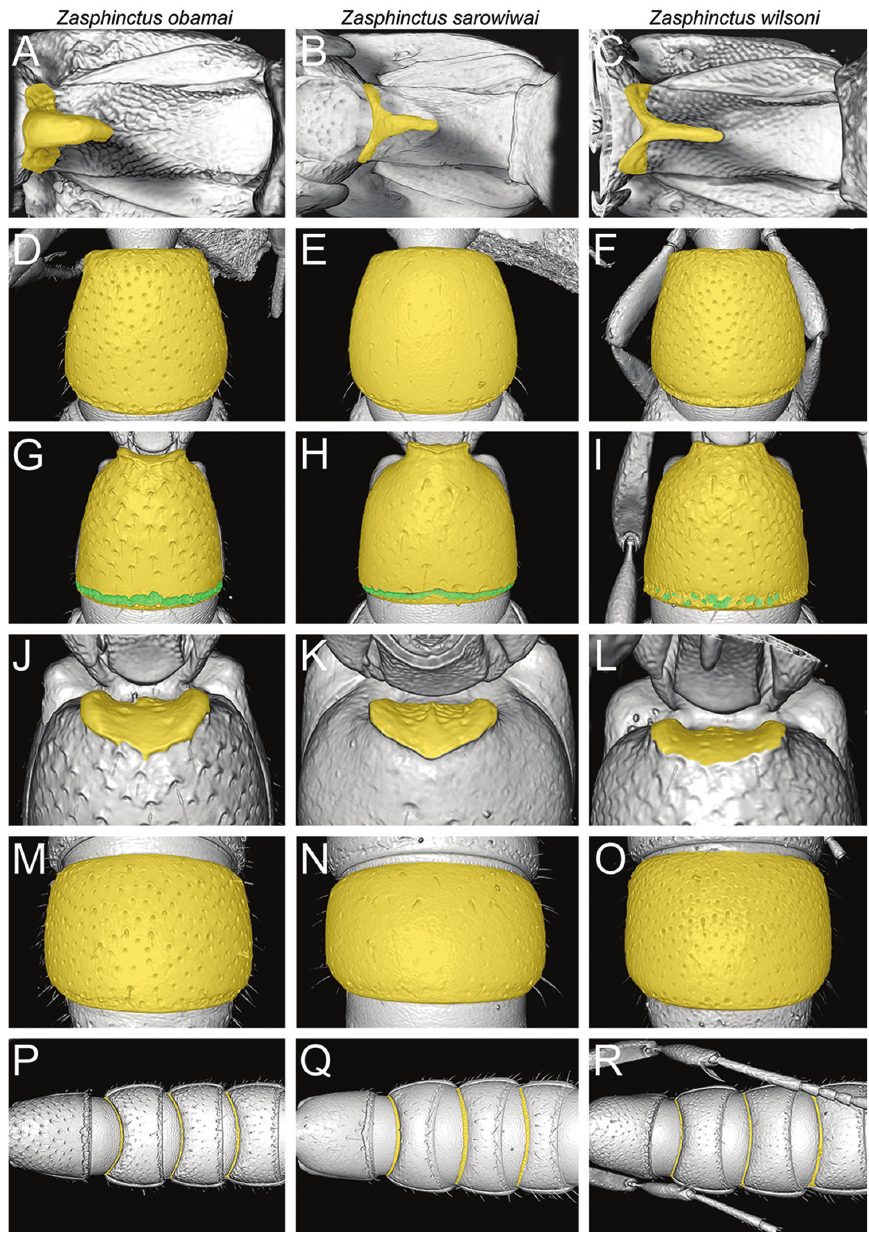
Figure 6. Illustrated diagnostic character matrix based on micro-CT images used for species delimitations ( Z. obamai = left column, Z. sarowiwai = middle column, Z. wilsoni = right column). A, B, C Subpetiolar process of petiolar sternum in ventral view (virtually dissected) D, E, F Abdominal segment III in dorsal view G, H, I Abdominal segment III (orange) in ventral view with posterior end (green) J, K, L Abdominal segment III in anteroventral view showing prora (virtually dissected) M, N, O Abdominal segment VI in dorsal view P, Q, R Abdominal segments III, IV, V, and VI in ventral view showing girdling